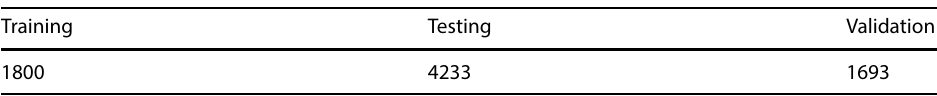
The training and testing data are randomly selected. 20% of the dataset is reserved for testing data. 10% of the remaining (8% of the original) images are used for validation. The remaining data is selected in batches of 300 to train for 200 epochs 6 times for a total of 1800 training